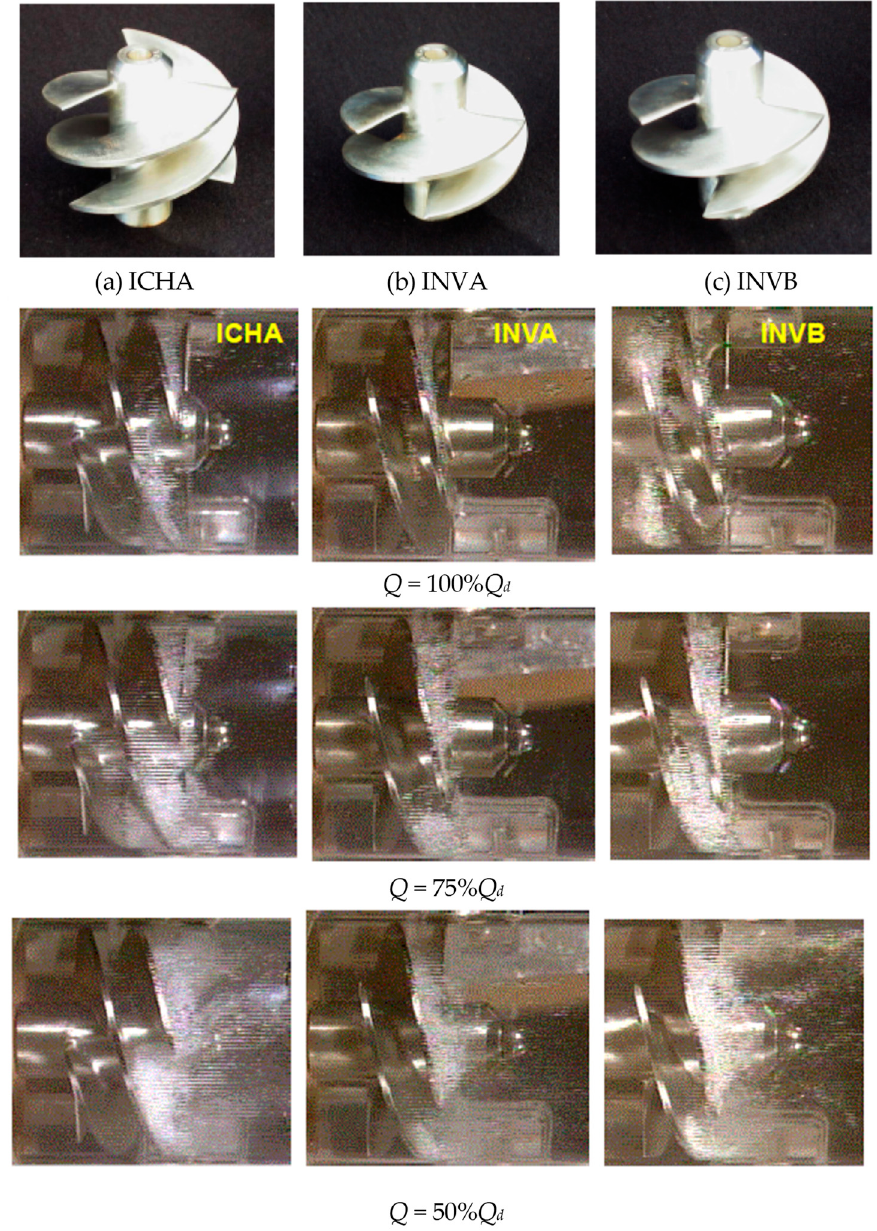
Figure 12. Cavitation visualization of different pump inducers in the experiment. ICHA represents conventional design of pump inducer, and INVA and INVB represent inverse designs of pump inducers with different blade loading distributions [22].